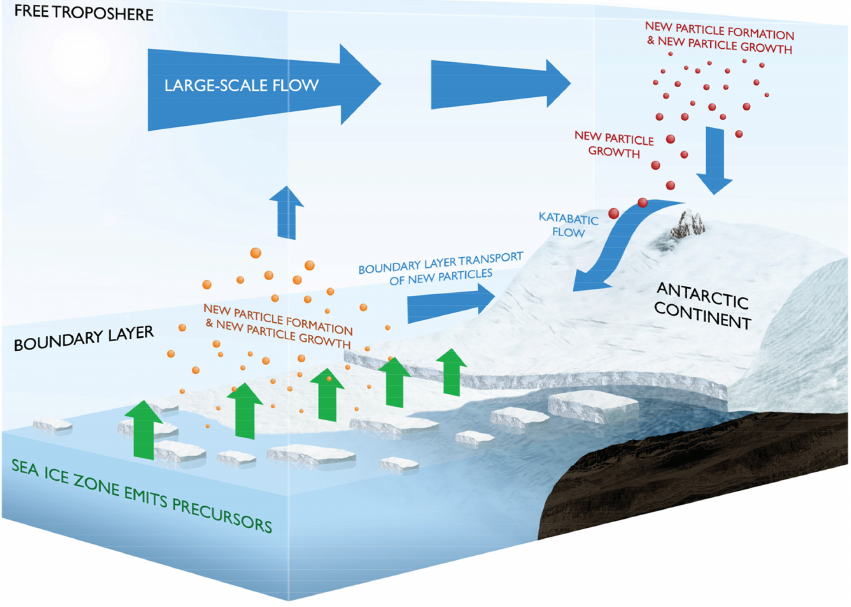
Figure 8. Schematic illustrations of the ultrafine new particle formation (NPF) and new particle growth (NPG) aerosols in Antarctica.